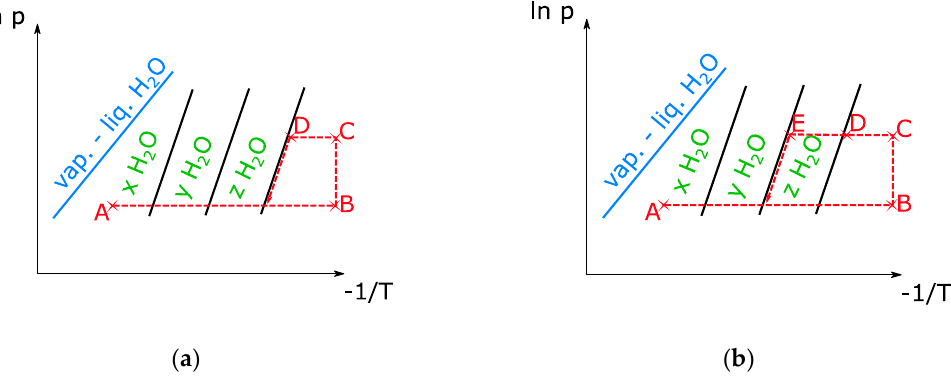
Figure 6. Clapeyron diagrams of equilibrium tests for H2O. Cycle for the determination of the lowest hydration step ( a ) and the second lowest hydration step ( b ).